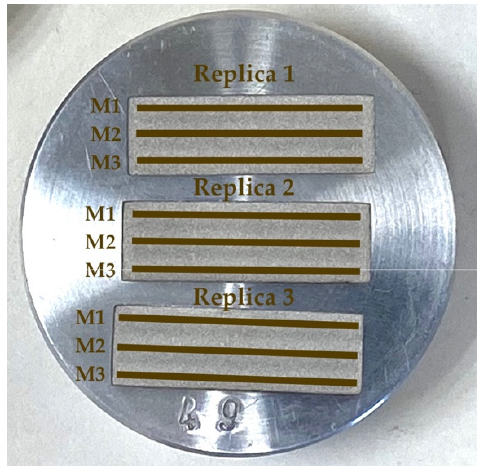
Figure 5. Roughness measurement lines in workpiece.